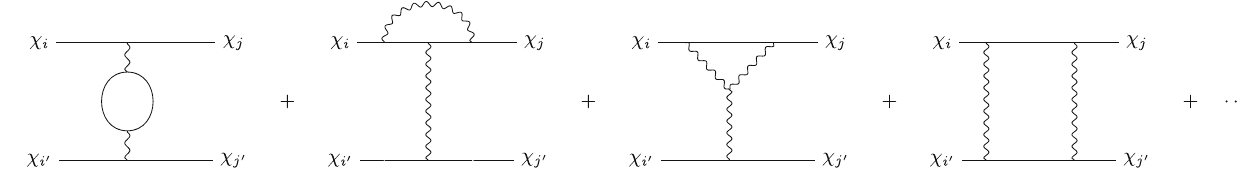
Fig. 3 Examples of Feynman diagrams contributing at NLO to the non-relativistic potentials as estimated in Eq.